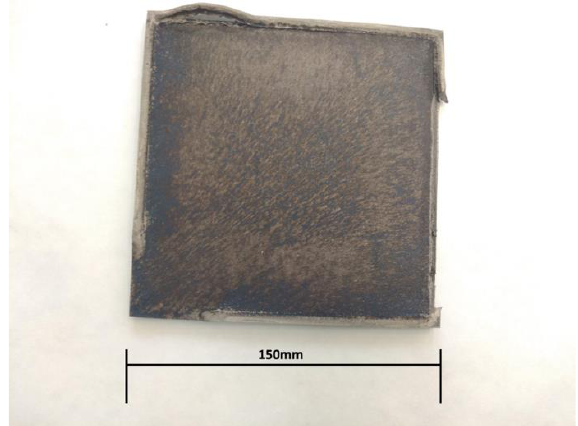
Figure 2. Titanium sheet after explosive hardening.